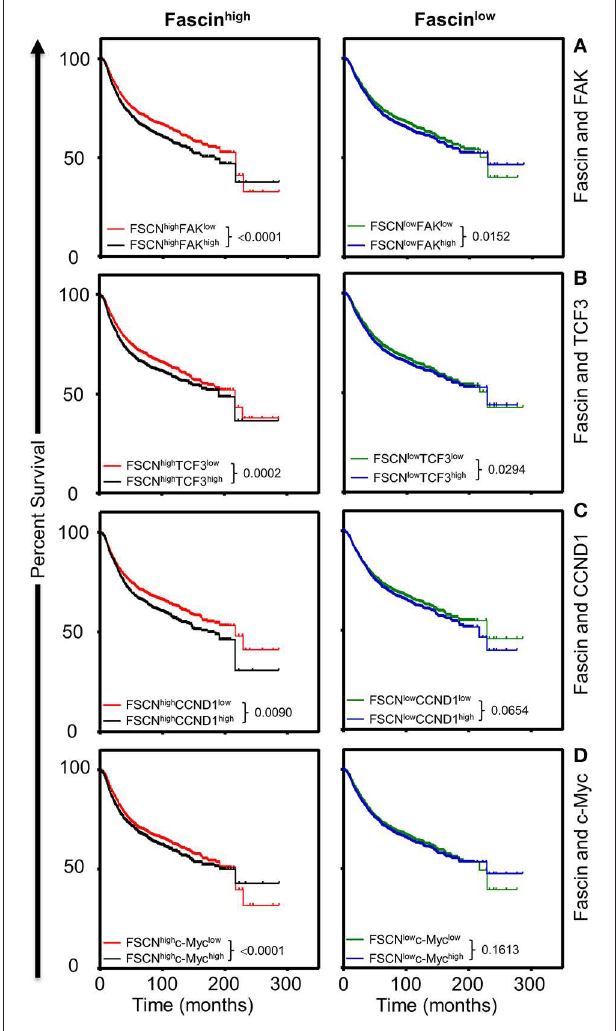
FIGURE 7 | (A–D) The influence of FAK high and high β -catenin downstream targets on poor survival is more significant in fascin high breast cancer patients. Kaplan–Meier plot showing the significance of FAK and β -catenin downstream targets on RFS ( n = 3,951) according to fascin expression (fascin high and fascin low ). Patients were grouped into fascin high (left) and fascin low (right), and the significance of the respective gene expression in each group was calculated using the log-rank test. P -values are indicated on each